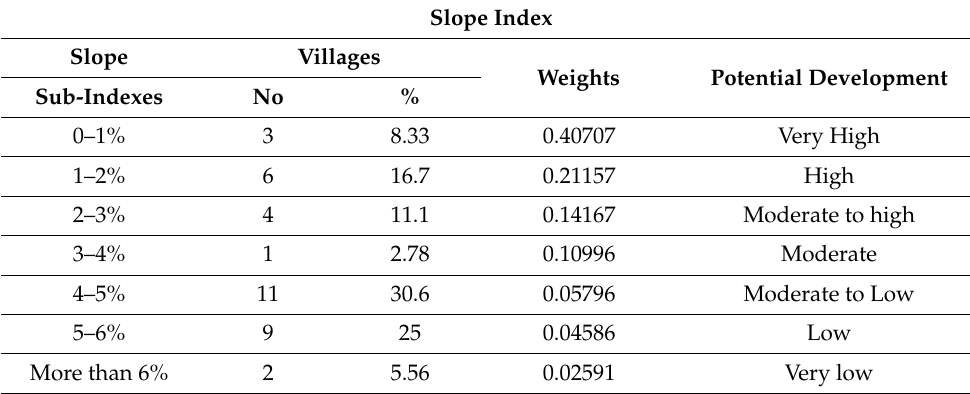
Table 5. Classification of “Slope” index with the weights assigned by the experts. Slope Index Slope Villages